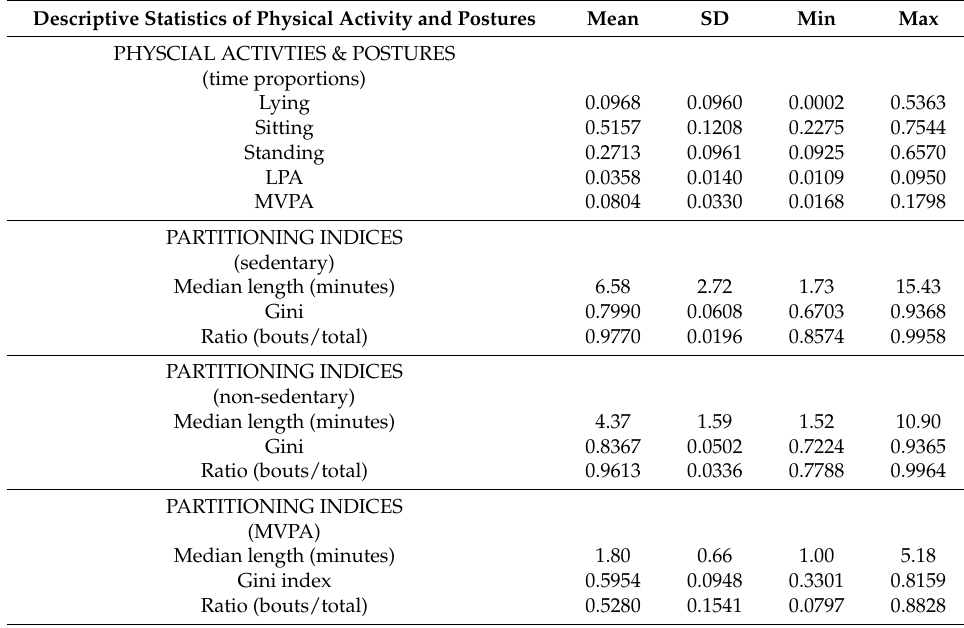
Table 1. The top section of the table shows the arithmetic mean, standard deviation (SD), minimum and maximum for the time proportion devoted to each physical behavior ( n = 131). The bottom sections show the same statistics for various partitioning indices of sedentary time (SB, i.e., lying or sitting), non-sedentary time (NSB, i.e., standing, Light Physical Activity (LPA), Moderate to Vigorous Physical Activity (MVPA)), and MVPA